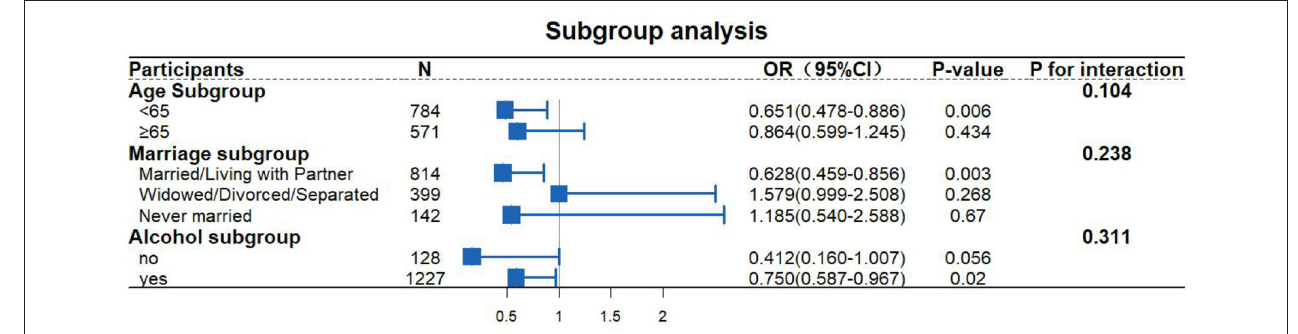
FIGURE 3 | Subgroup